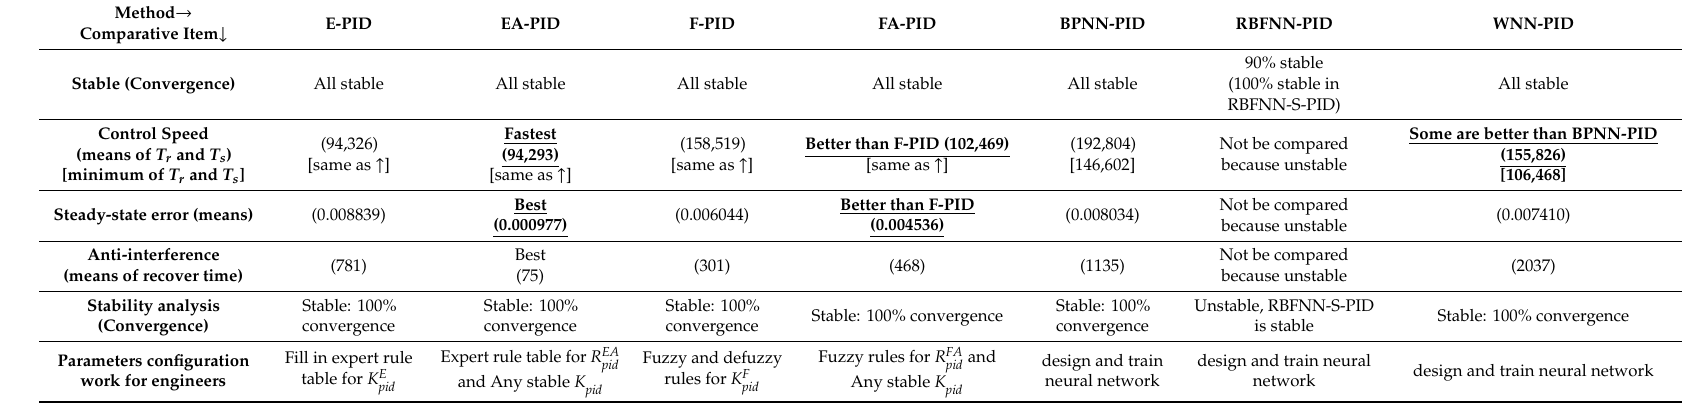
Table 10. Comparison of di ff erent intelligent control